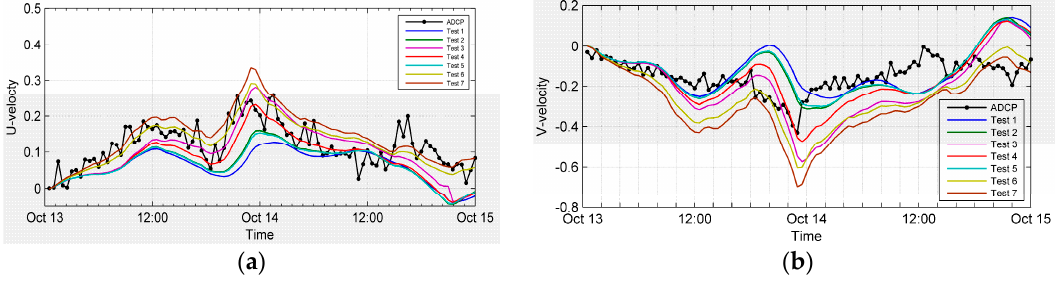
Figure 10. Measured and predicted depth ‐ averaged horizontal velocities of the calibration tests. ( a ) U ‐ velocity; ( b ) V ‐ velocity.